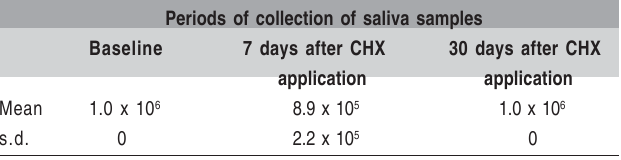
Table 1: Means and standard deviations of salivary MS levels (CFU mL -1 of saliva) before (baseline) and 7 and 30 days after application of the CHX gel containing saccharin (n = 9 subjects).